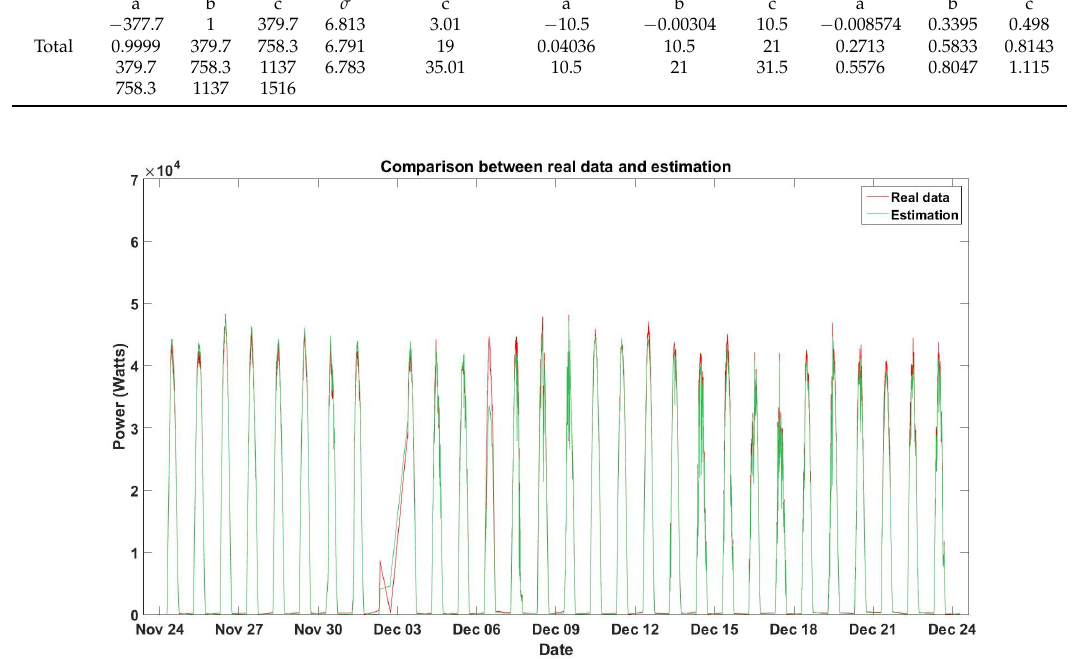
Figure 12. ANFIS results from